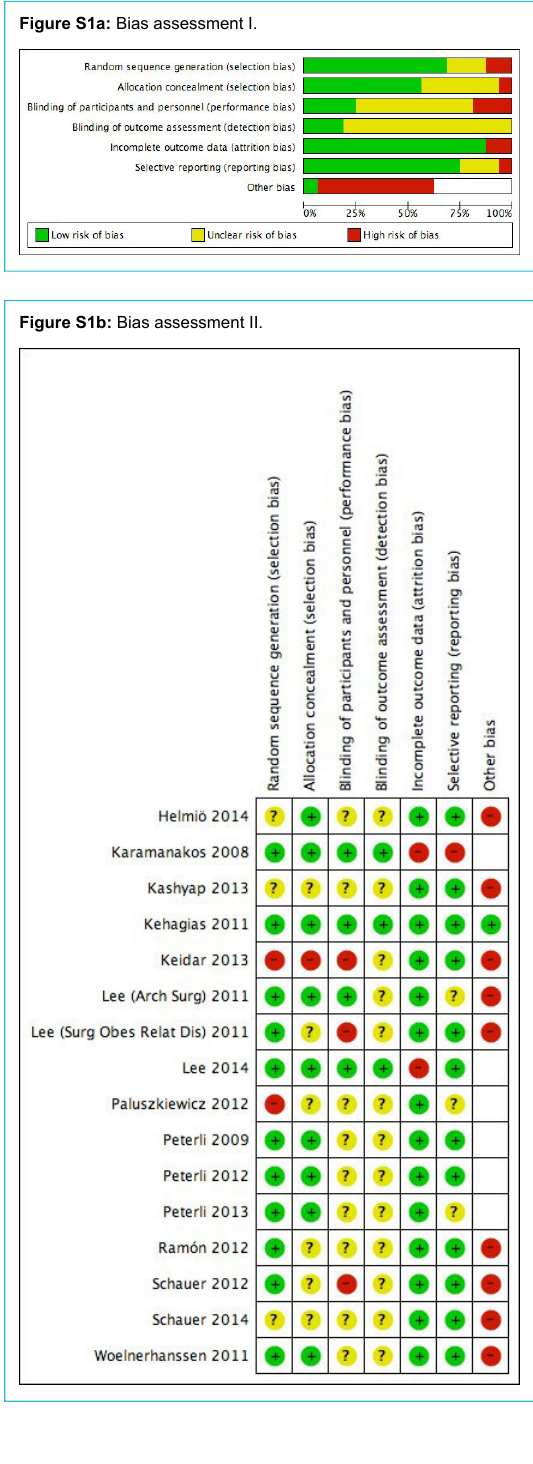
Figure S1a: Bias assessment I.